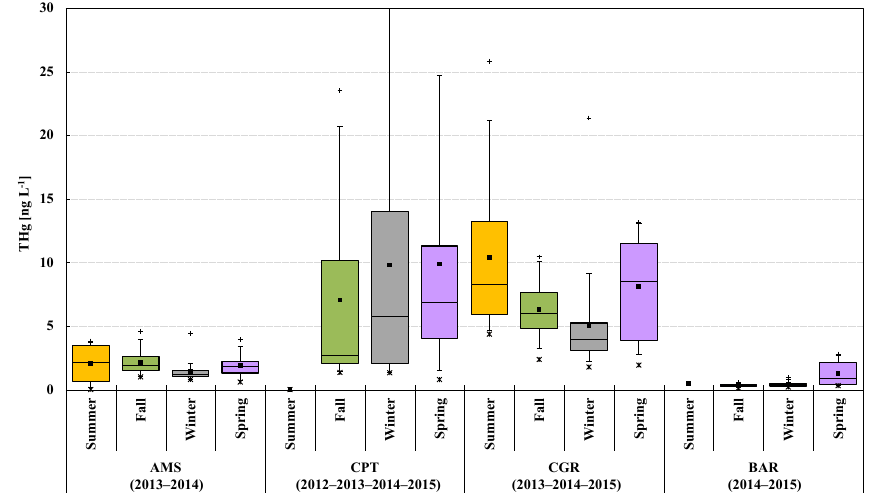
Figure 12. Seasonal distribution of volume-weighted THg concentration in precipitation at the four GMOS sites in the Southern Hemisphere from 2012 to 2015. Each box includes the median (midline), mean ( (cid:4) ), 25th and 75th percentiles (box edges), 5th and 95th percentiles (whiskers), minimum ( ∗ ), and maximum ( + ).